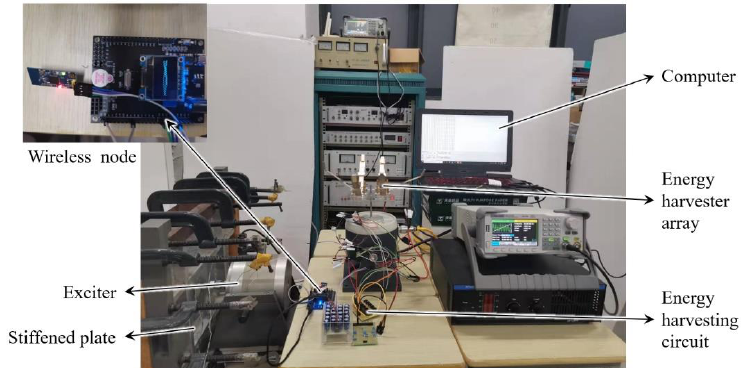
Figure 24. Auxiliary power supply experiment of wireless sensor nodes.